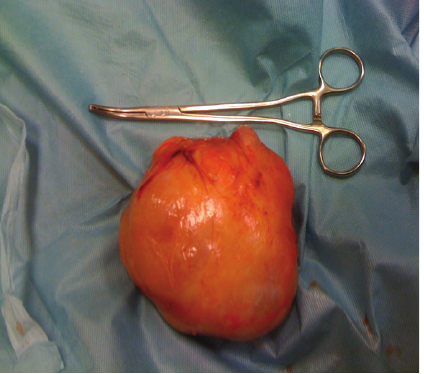
Figure 1: Giant leiomyoma (10cm in diameter) of the Retzius